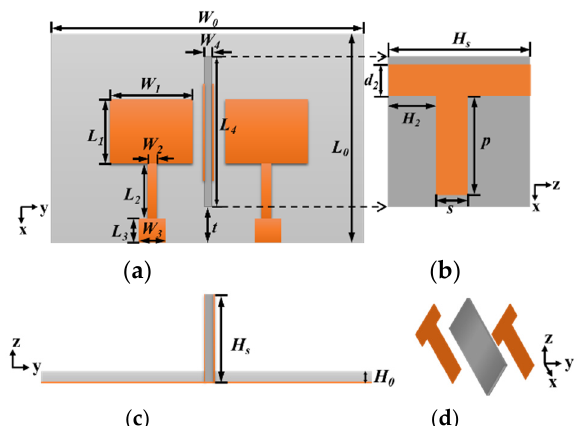
Figure 1. Antenna configuration and decoupling wall: ( a ) The whole structure, ( b ) side view of the proposed antenna, ( c ) front view of the wall, and ( d ) detailed wall.